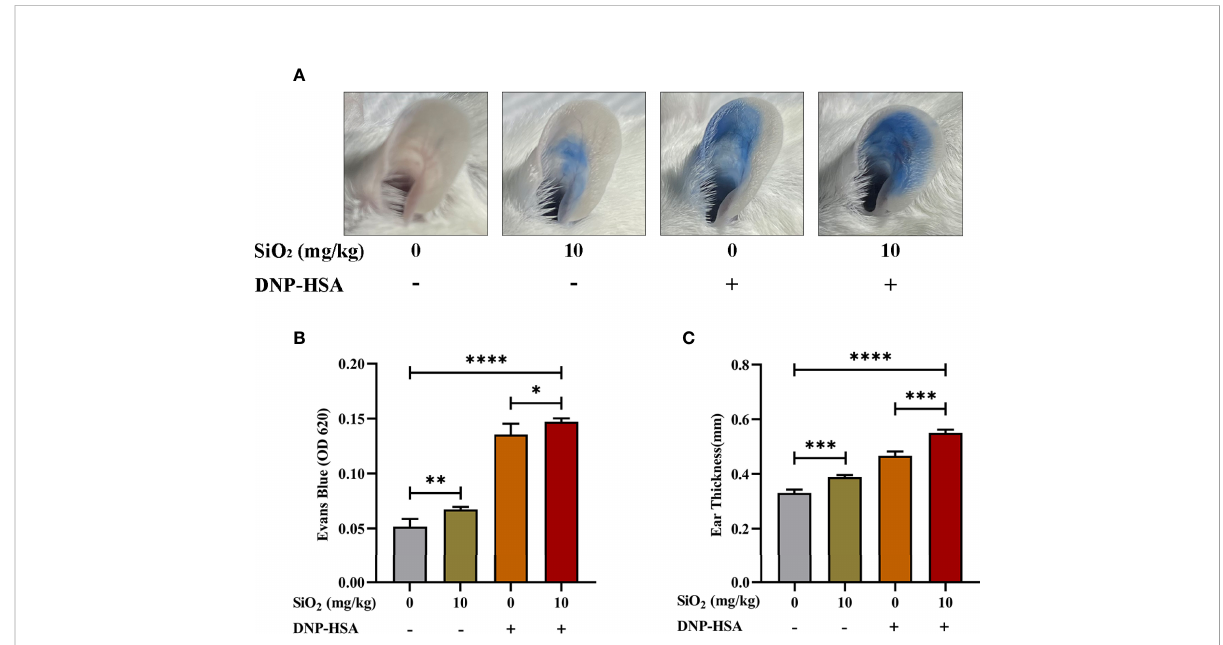
FIGURE 2 Nano-SiO 2 particles promote IgE-mediated PCA in mice. (A) Representative images of PCA mouse ears. (B) Nano-SiO 2 particles increase PCA- induced Evan ’ s blue extravasation (OD620nm) and (C) promote PCA-induced ear thickening. The data are presented as the mean ± SD. The unpaired t test or ordinary one-way ANOVA was used to compare different groups. * P < 0.05, ** P < 0.01, *** P < 0.001, **** P <